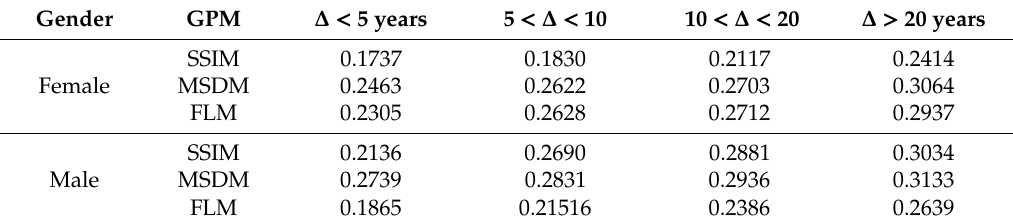
Table 4. Mean scores of generic perception-based mode (GPM) evaluation mode: structural similarity